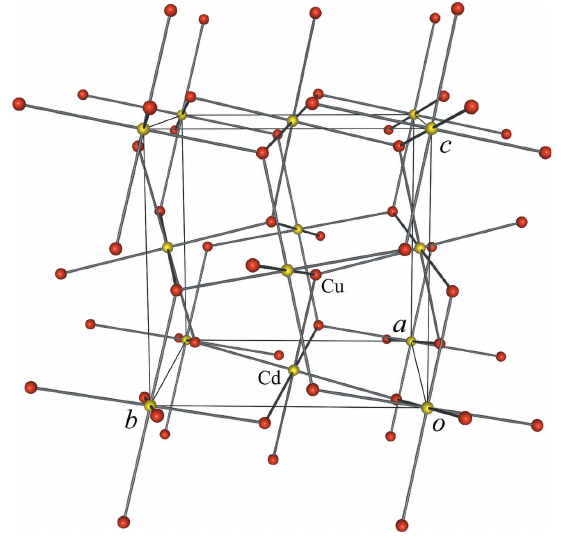
Figure 2 Pyrite net ( pyr ) of the coordination polymer [CdCu 2 (CN) 6 ] n 2 (cid:2) . The CN (cid:2) ligands linking the Cd II (octahedral coordination sphere) and the Cu I (trigonal-planar coordination sphere) ions are represented as solid lines.